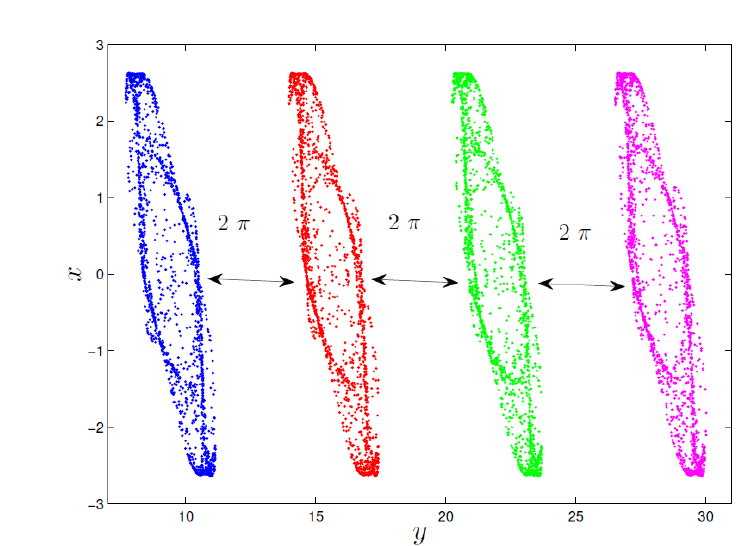
Figure 7. Hidden chaotic attractors for a 1 = 2.6, a 2 = 1.1, a 3 = 0.001 with y 0 = 2 + 2 π (blue), y 0 = 2 + 4 π (red), and y 0 = 2 + 6 π (green), y 0 = 2 + 8 π (magenta).